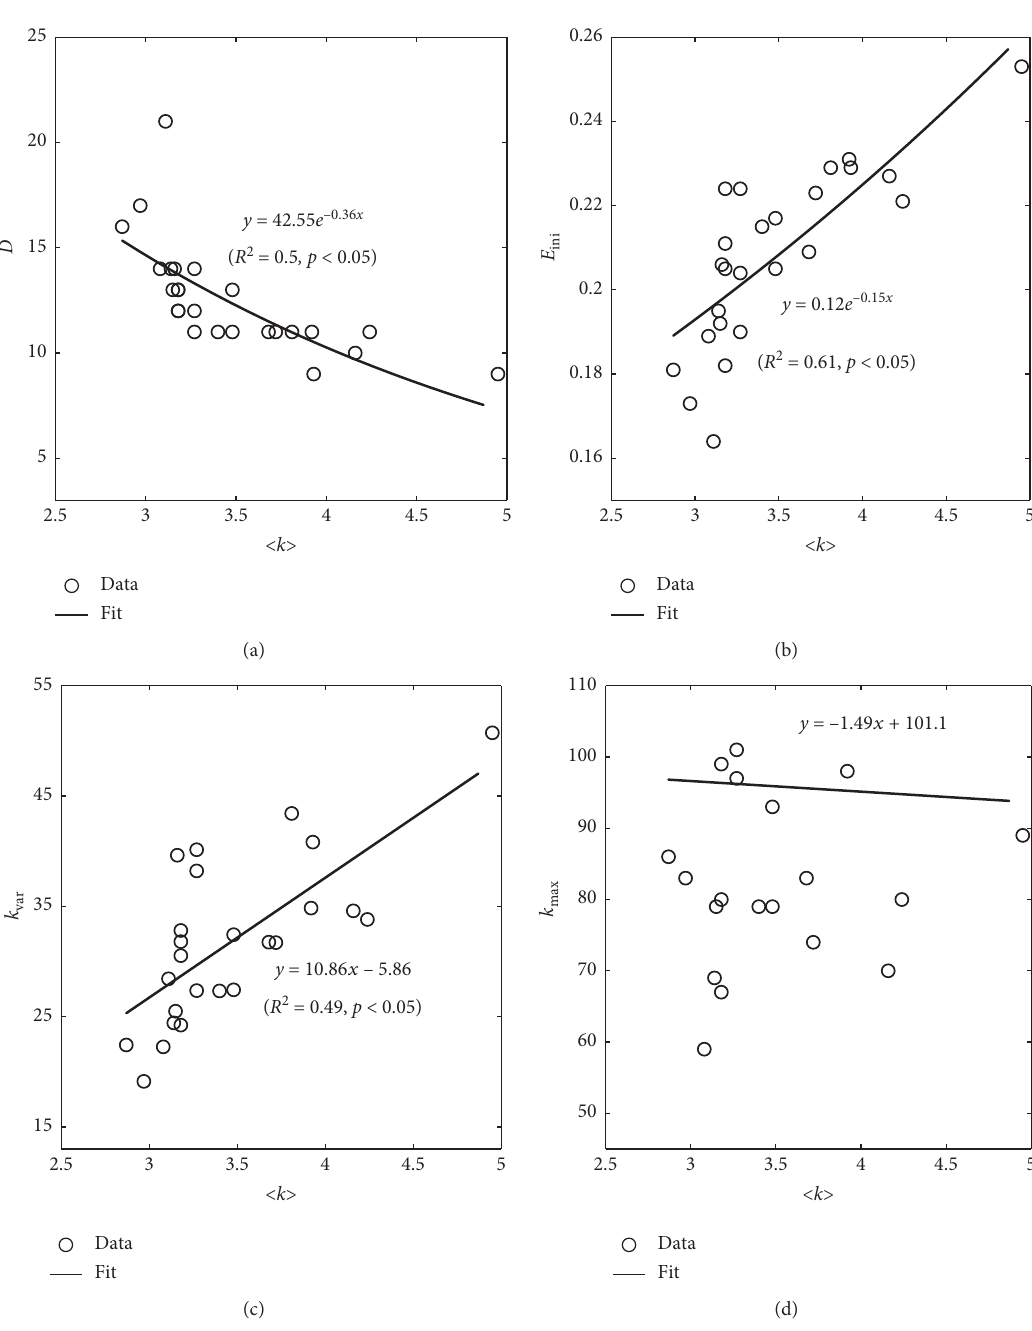
Figure 3: Trends of network statistics over < k > . (a) Diameter, (b) initial efficiency, (c) variance of k , and (d) maximum k